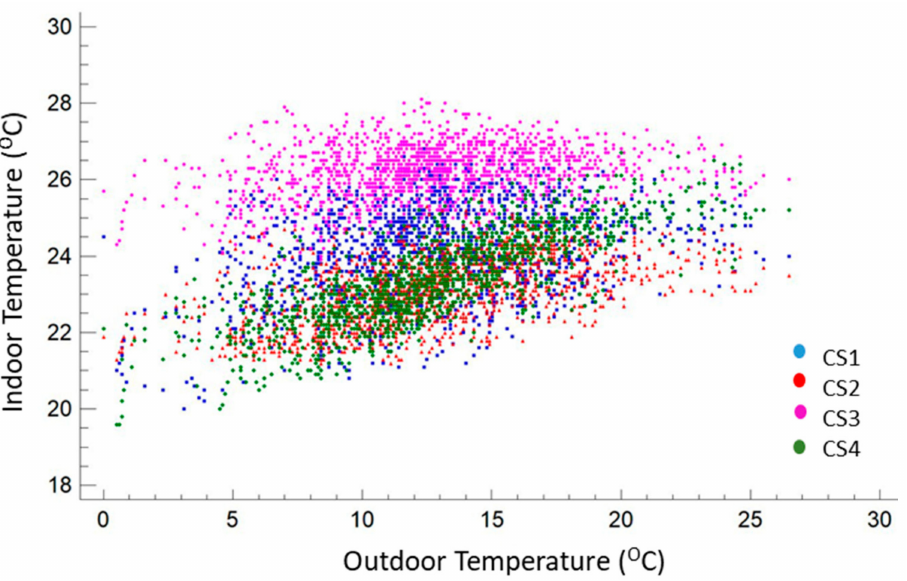
Figure 7. Outside temperature vs. inside temperature in the case studies in Madrid. CS1 (blue), CS2 (red), CS3 (magenta), CS4 (green).